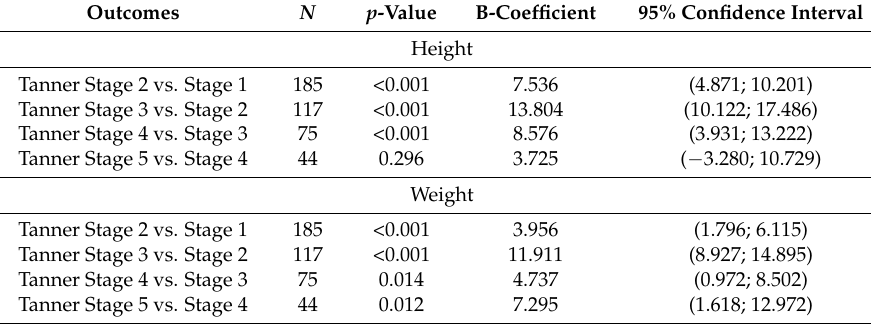
Table 3. Multivariate association between anthropometric variables and tanner stage for boys from the rural Western Cape after adjusting for lived on farm or not, family income, birth weight, general health condition, prenatal exposures, and testicular related